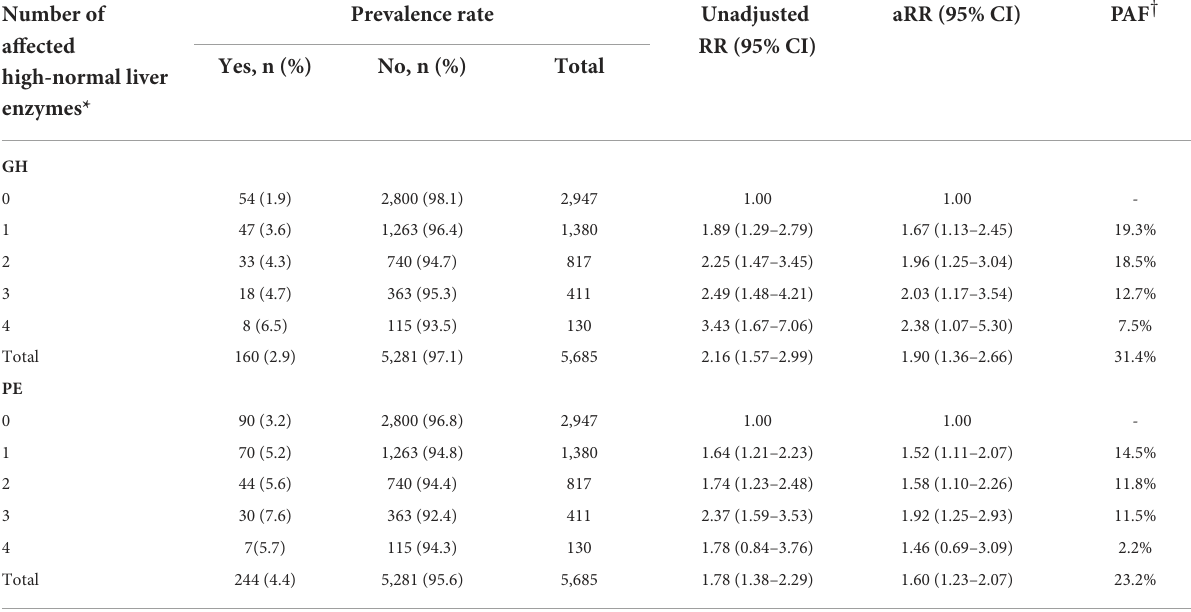
TABLE 3 Risk ratios and population attributable risk of hypertensive disorders by numbers of affected high-normal liver enzymes in early